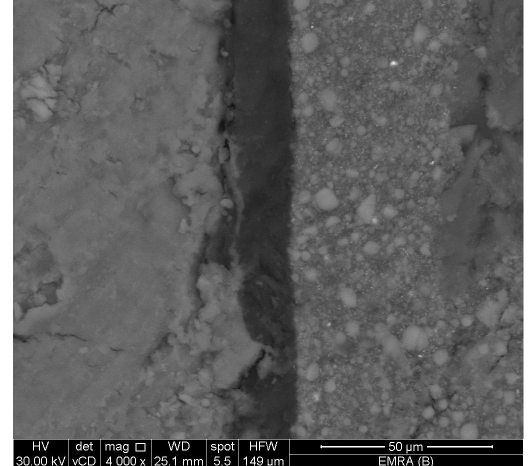
Figure 1. Selected scanning electron microscopy shows absence of gap formation in dentin for teeth treated with total- etch technique. Image representative of 8 teeth.